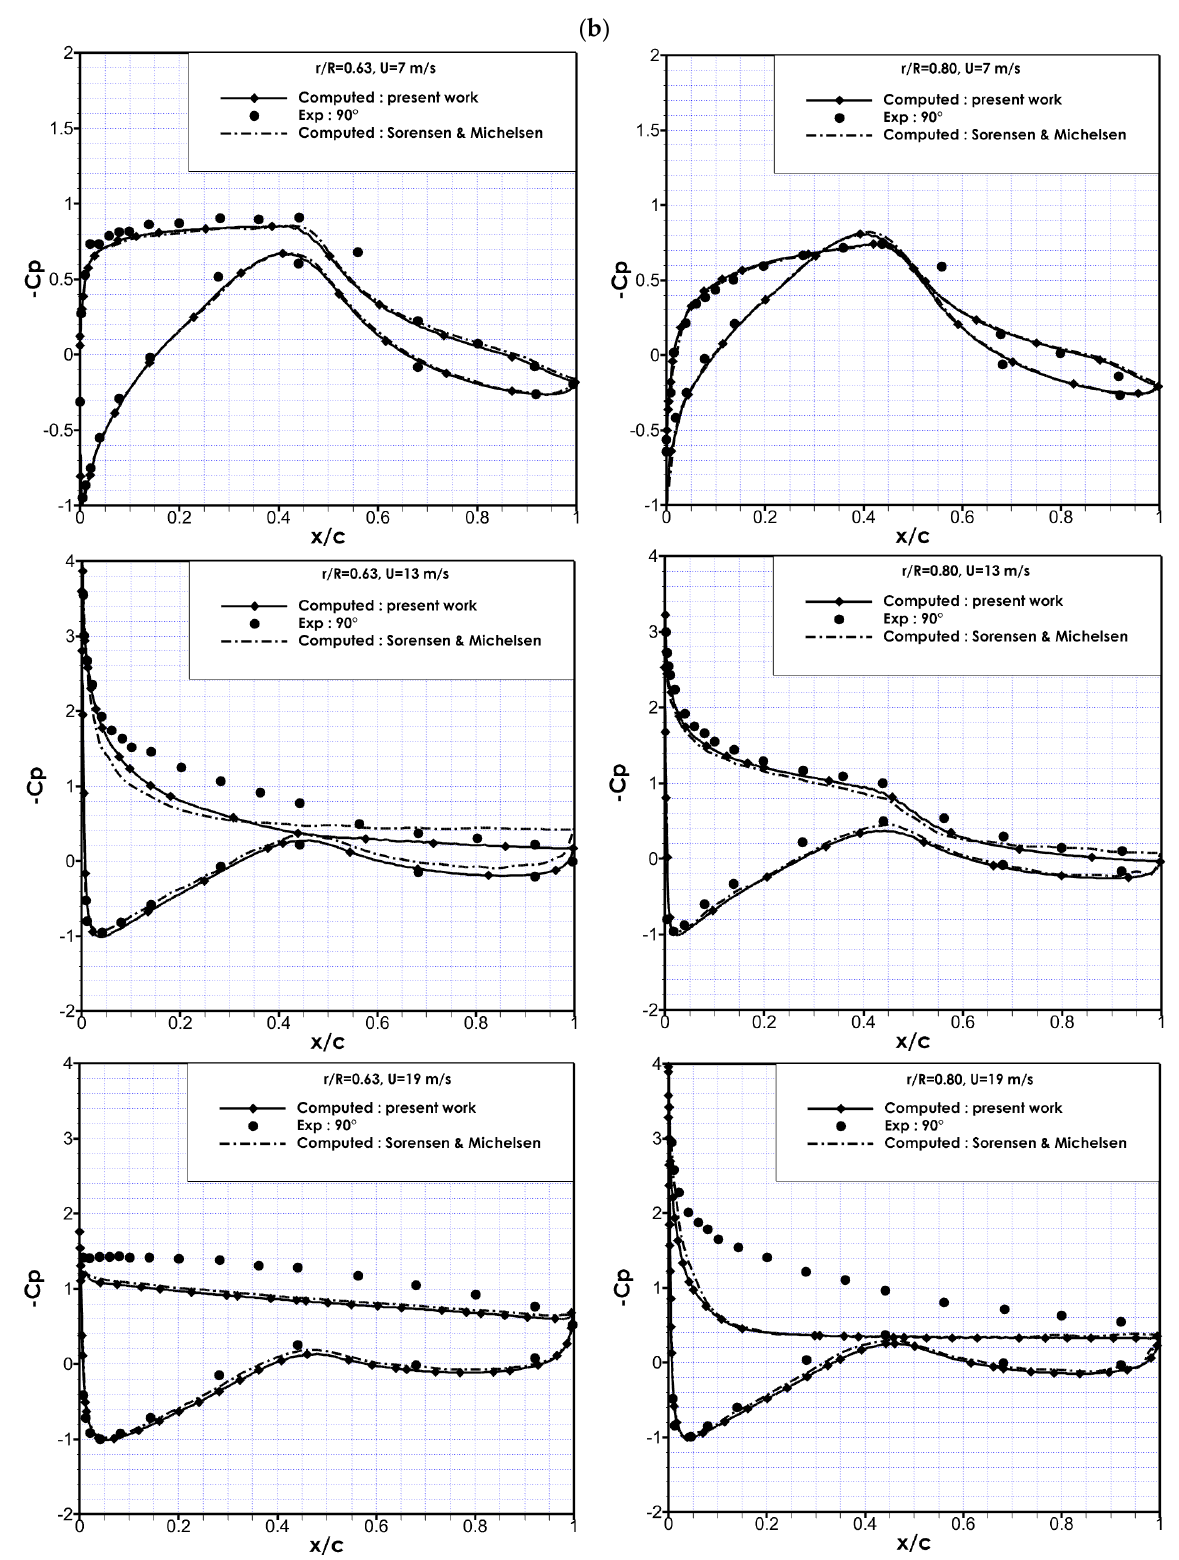
Figure 5. Experimental and computed pressure coefficient at different spanwise sections and wind speeds of 7 m s − 1 , 13 m s − 1 , and 19 m s − 1 for NREL Phase II [52,55]: ( a ) r/R = 0.30 and r/R = 0.47, ( b ) r/R = 0.63 and r/R = 0.80.